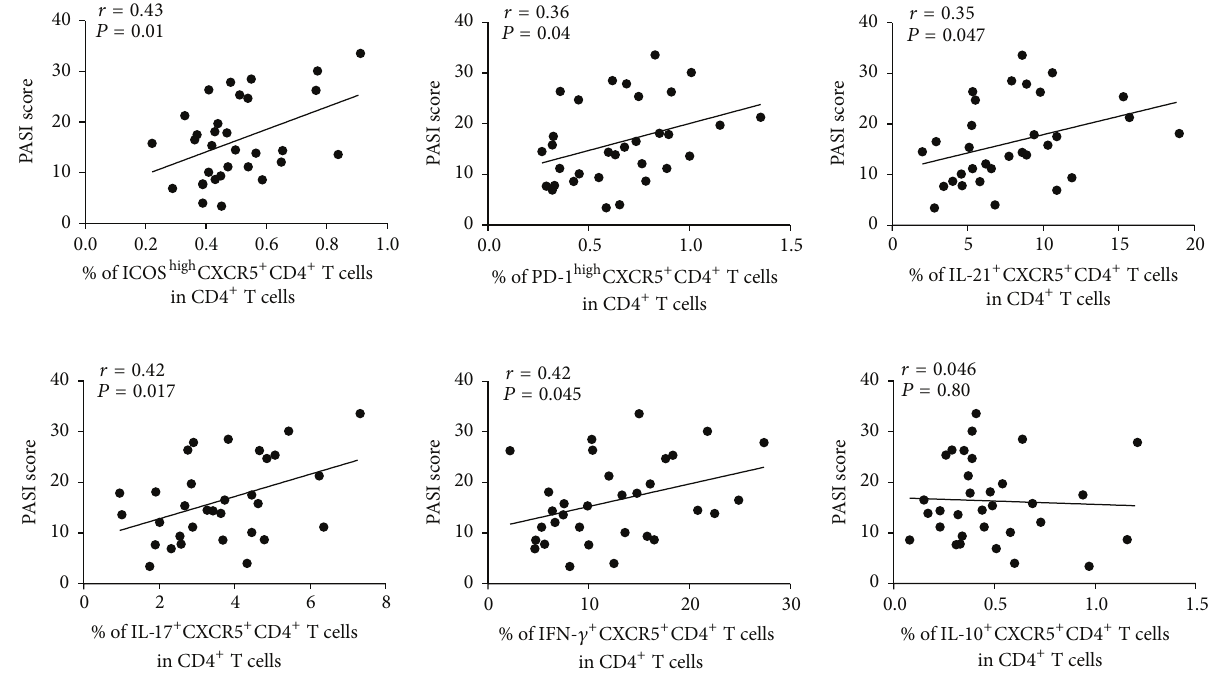
Figure 4: Correlations between the levels of functional markers on cTfh cells and PASI score. The ICOS and PD-1 expression on cTfh cells have positive correlations with PASI score. The positive relationships are also found between the levels of IL-21, IL-17, and IFN- 𝛾 secreted by cTfh cells and PASI score. However, the IL-10 secreted by cTfh cells has no relationship with PASI score in psoriasis patients. Correlative coefficients and 𝑃 values are